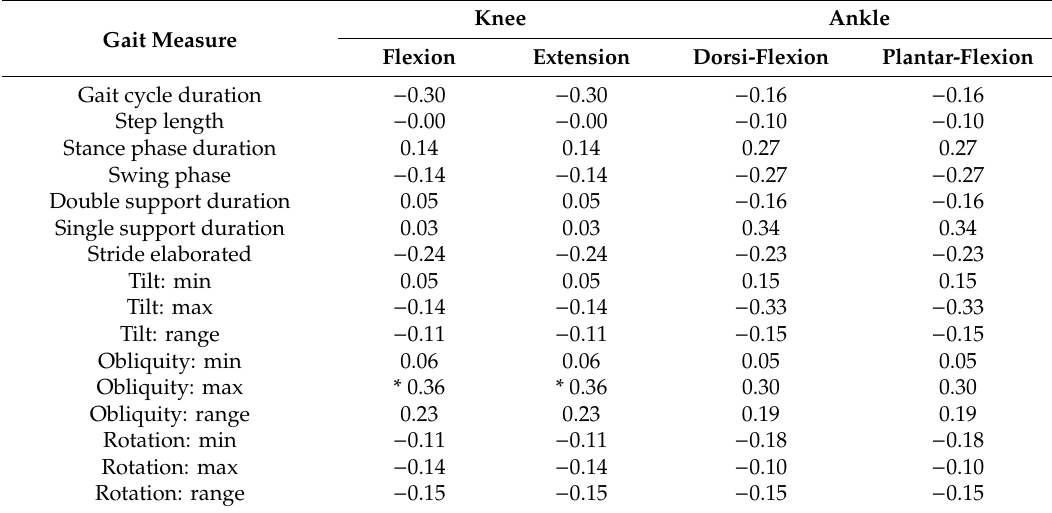
Table 5. Correlation between the lower-limb knee and ankle muscles in the MMT and the gait variables of hemiplegic stroke patient’s a ff ected